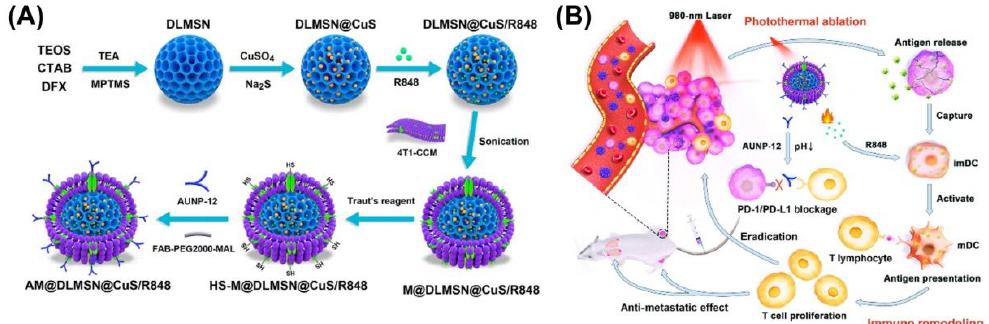
Figure 8. ( A ) Schematic illustrations for the preparation and ( B ) synergistic effects of AM@DLMSN@CuS/R848 against triple-negative breast cancer (TNBC) by combining photothermal ablation and immune remodeling. Reproduced from [144] with permission, copyright 2020, American Chemical Society.